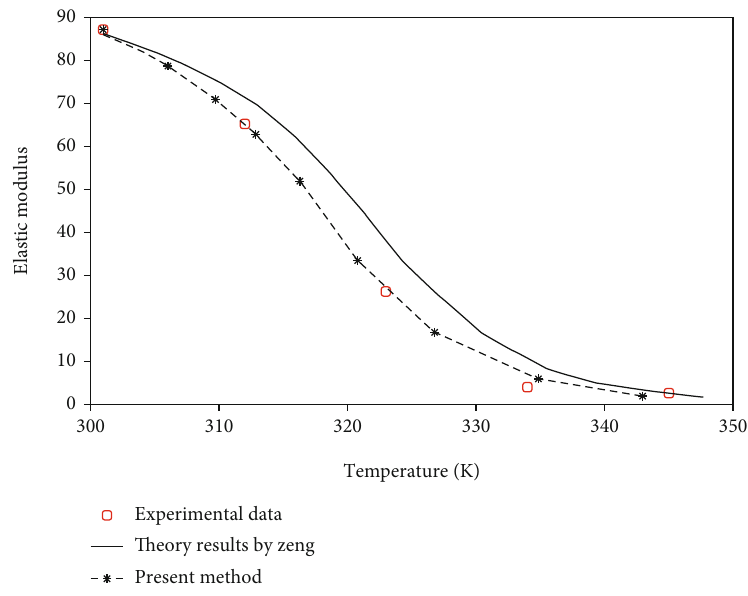
Figure 5: A comparison of elastic modulus with respect to ambient temperature when the FVF = 5 % .